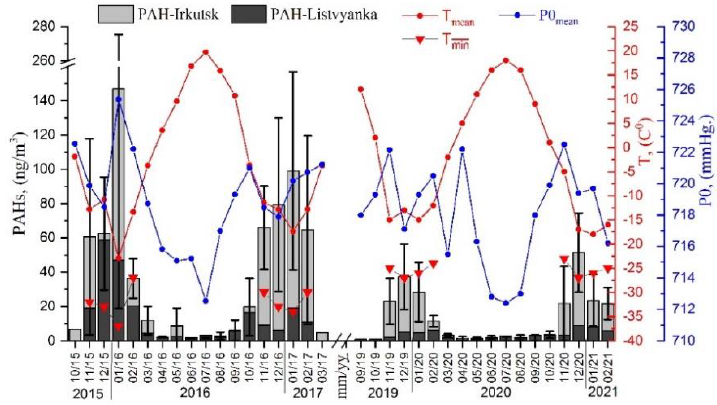
Figure 2. Average monthly total concentrations of PAHs (ng/m 3 ) ( ± standard deviation), air tem- perature (T ◦ C) and ground-level pressure (P0) in Irkutsk and Listvyanka from 2015 to 2021 [13–15]. The minimum weighted average monthly temperature (T min) in the frosty period of the year (November – February) is shown by red triangles.